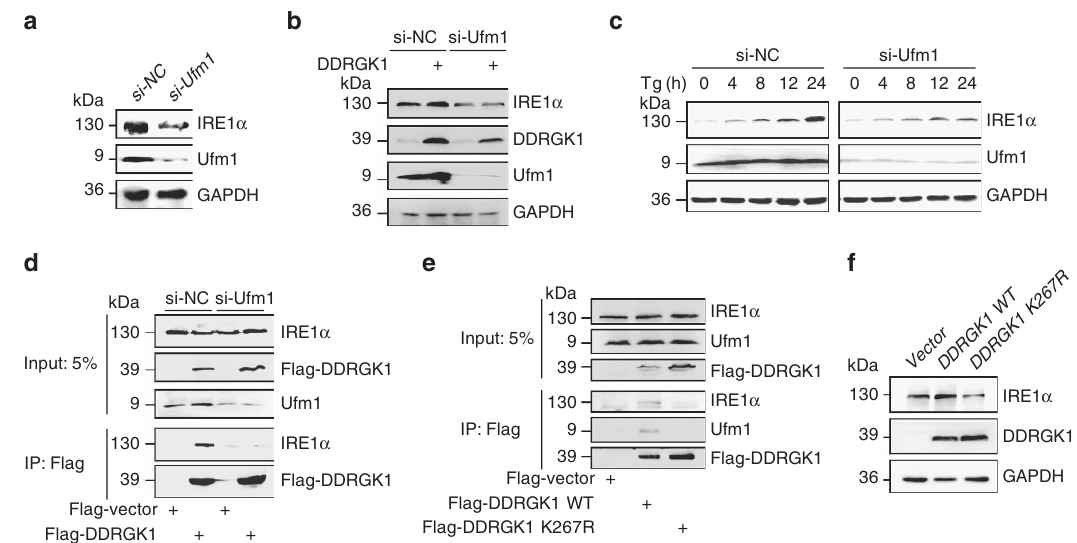
Figure 6 | Ufmylation is required for the interaction between DDRGK1 and IRE1 a . ( a ) MCF7 cells were transfected with either control siRNA or siRNA targeting Ufm1 for 72h. The protein levels of IRE1 a were determined by western blot. ( b ) Western blot analysis of IRE1 a in control and Ufm1-knockdown MCF7 cells expressing vector or DDRGK1. ( c ) The protein level of IRE1 a was determined by western blot in control and Ufm1-knockdown MCF7 cells after treatment with 2.5 m M Tg for the indicated times. ( d ) Western blot analysis of Flag M2 affinity gel immunoprecipitates in HEK293T control and Ufm1-knockdown cells expressing Flag-Vector or Flag-DDRGK1. ( e ) Western blot analysis of Flag M2 affinity gel immunoprecipitates in HEK293T cells transfected with Flag-Vector, Flag-DDRGK1 WT or K267R mutant. ( f ) Western blot analysis of IRE1 a in MCF7 cells transfected with Flag-Vector, Flag-DDRGK1 WT or K267R